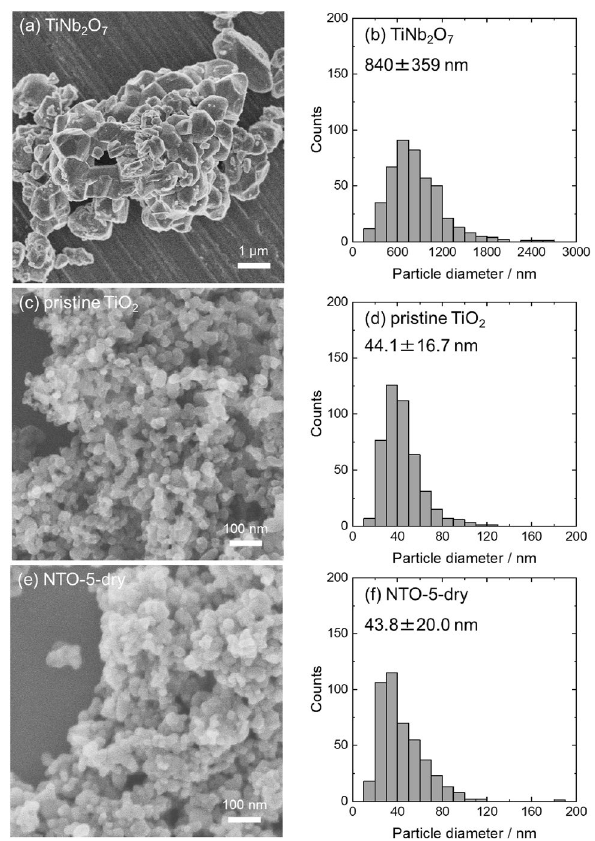
Figure 1. ( a ), ( c ), ( e ) SEM images and ( b ), ( d ), ( f ) corresponding particle diameter distributions (statistics of 450 particles) of synthesized TiNb